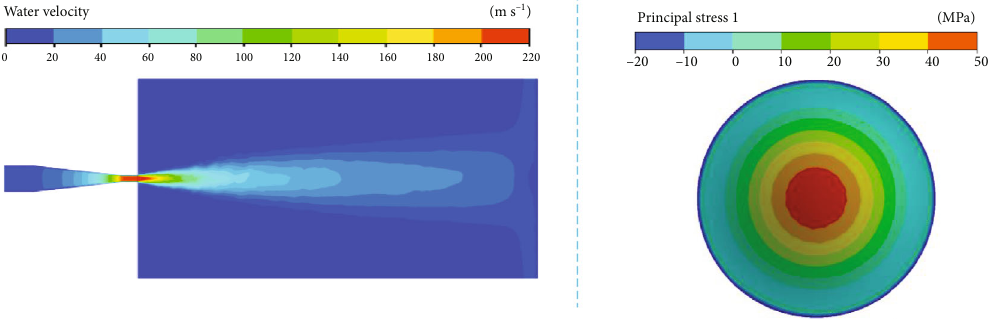
Figure 5: Velocity and stress distribution of HPWJ impact on the plate at di ff erent target distances.